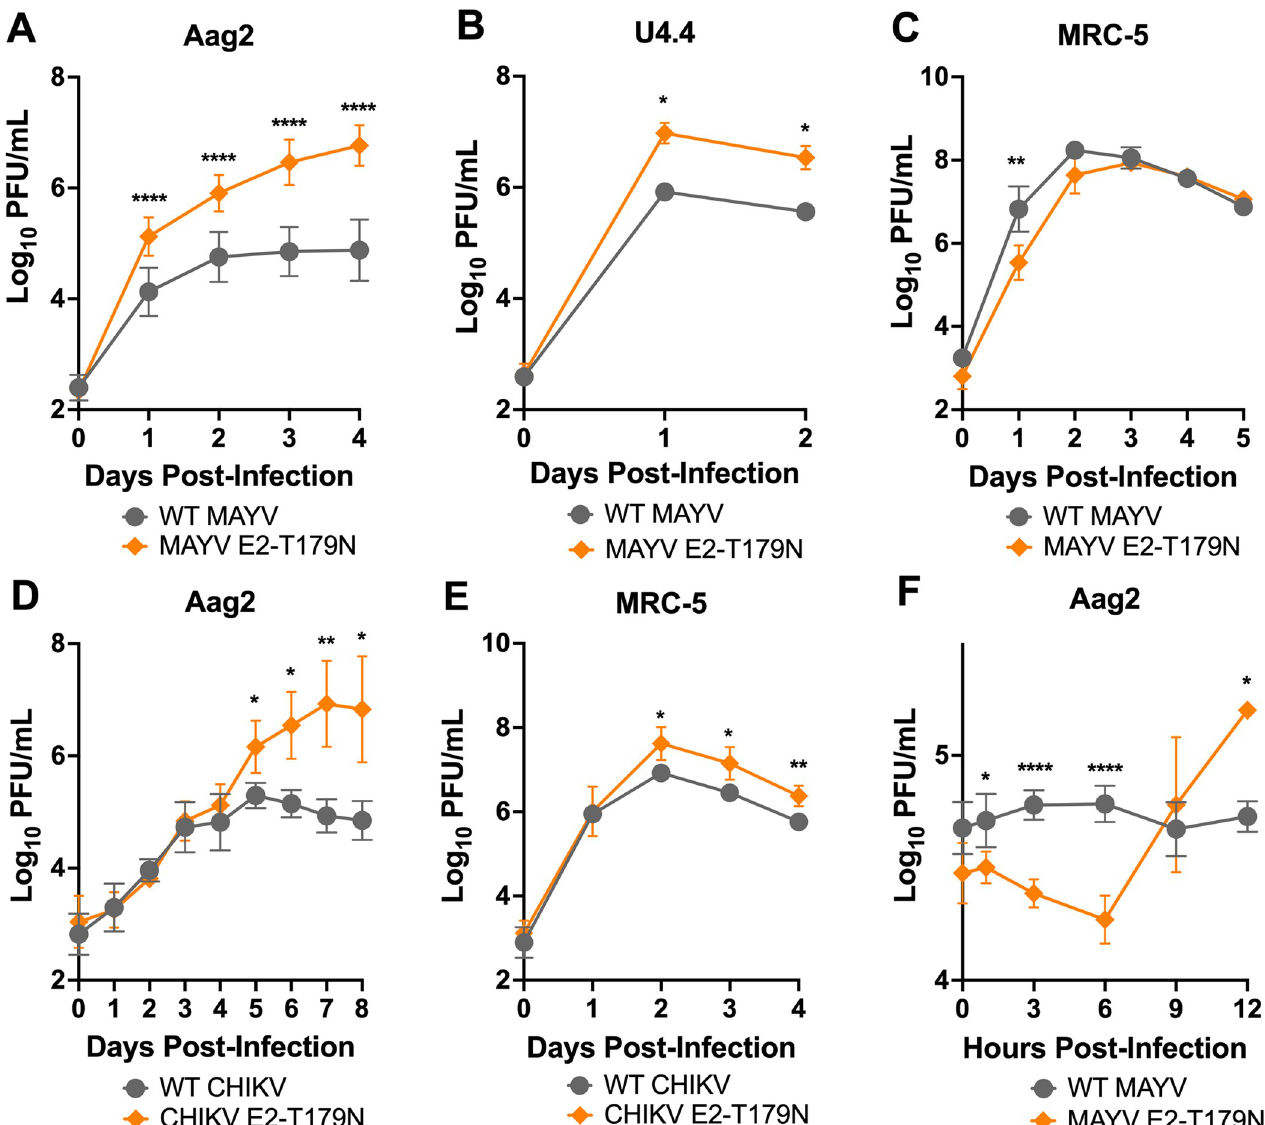
Fig 3. E2-T179N increases viral replication of MAYV and CHIKV in insect cells and causes early release. A-C: Replication of WT MAYV and MAYV E2-T179N in insect and human cells. Aag2 ( A ) and U4.4 ( B ) cells were infected with WT MAYV or MAYV E2-T179N at a MOI of 0.1, while MRC-5 were infected at a MOI of 0.01 ( C ). Replication was assessed over time by plaque assay titration. Data represents the mean of 2 independent experiments apart from the U4.4 growth curve which is representative of three independent experiments. D-E: Replication of WT CHIKV and CHIKV E2-T179N in insect and human cells. Aag2 cells were infected with WT CHIKV or CHIKV E2-T179N at a MOI of 0.1 ( D ), while MRC-5 were infected at a MOI of 0.01 ( E ). Replication was assessed over time by plaque assay. Data represents the mean of 2 independent experiments. F: One-step growth curve of WT MAYV and MAYV E2-T179N in insect cells. Aag2 cells were infected with WT MAYV and MAYV E2-T179N at an MOI of 10. Replication was assessed over time by plaque assay. Data represent the mean of 2 independent experiments. Statistical analysis: Two-Way ANOVA using Sˇı´da´k’s multiple comparisons; * = p < 0.05; ** = p < 0.01; **** = p < 0.0001. Error bars represent the standard deviation. https://doi.org/10.1371/journal.ppat.1010491.g003 in 3T3 Mxra8 KO cells compared to WT 3T3 cells at 1 and 2 d.p.i., indicating Mxra8 is impor- tant for replication ( Fig 4D ; p = 0.0095, p = 0.0007). Similarly, replication of MAYV E2-T179N was reduced at 1 and 2 d.p.i. in 3T3 Mxra8 KO compared to WT 3T3 cells ( Fig 4E ; p = 0.0126, p = 0.0485). To compare MAYV E2-T179N to WT MAYV, we calculated the mean change in log -transformed virus titer between WT MAYV and MAYV E2-T179N in 3T3 10